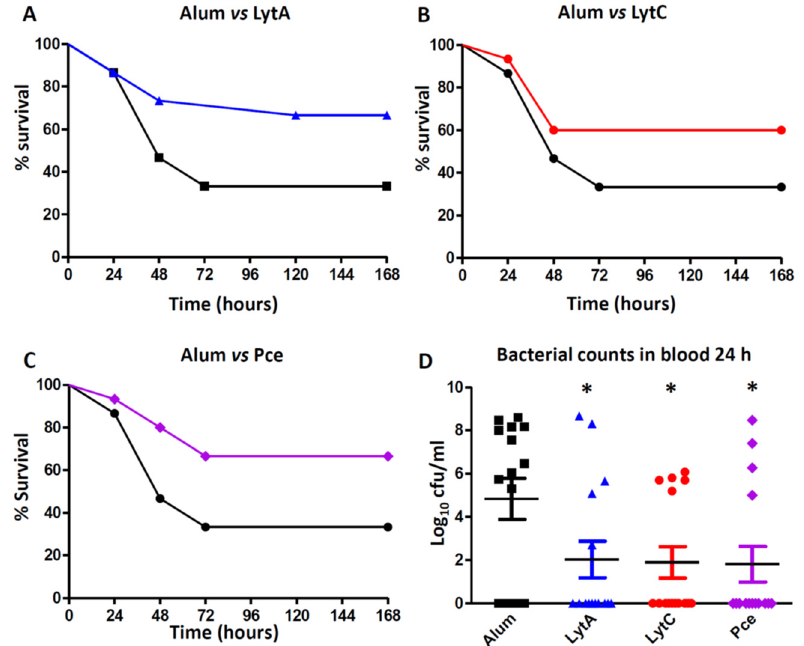
Figure 5. Protection mediated by LytA, LytC, or Pce against pneumococcal sepsis caused by strain 48 (serotype 23F). Mice were vaccinated with Alum or with 20 µ g of the specific protein (LytA, LytC, or Pce) mixed with Alum. ( A ) Survival in mice vaccinated with Alum (black line) or LytA-Alum (blue line). ( B ) Survival in mice vaccinated with Alum (black line) or LytC-Alum (red line). ( C ) Survival in mice vaccinated with Alum (black line) or Pce-Alum (purple line). ( D ) Bacterial counts in blood at 24 h from mice immunized with Alum or proteins (LytA, LytC, or Pce) mixed with Alum. Error bars represent the SDs and asterisks indicate statistical significance of vaccination with LytA, LytC, or Pce compared to the Alum group; * p < 0.05.